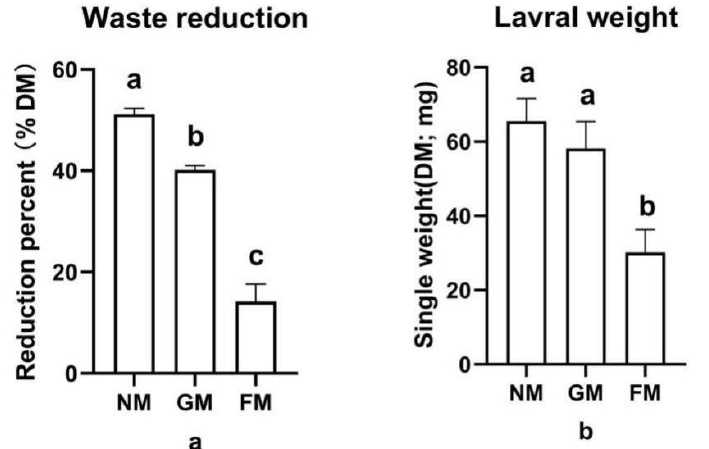
Figure 1. The waste reduction and weight of larvae fed with different fattening pig manure types: ( a ) waste reduction of different groups; ( b ) larval weight of different groups. a, b, c: results with no shared letter are significantly different from each